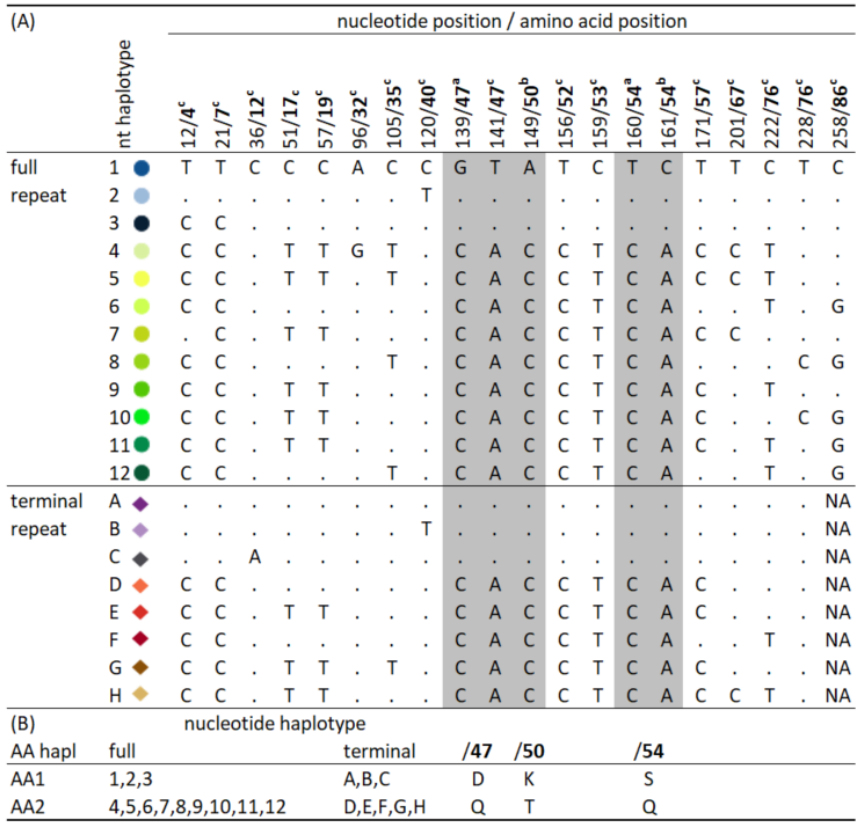
Figure 1. Multiple alignments within full (261 bp) and terminal (243 bp) repeats, respectively. ( A ) Haplotypes based on differences in nucleotide sequences and ( B ) amino acid haplotypes with corresponding AA changes. Non-synonymous substitutions are shown with grey background. Colour symbols are assigned to haplotypes to be used hereafter. a,b,c refer to the first, second and third codon positions, respectively.